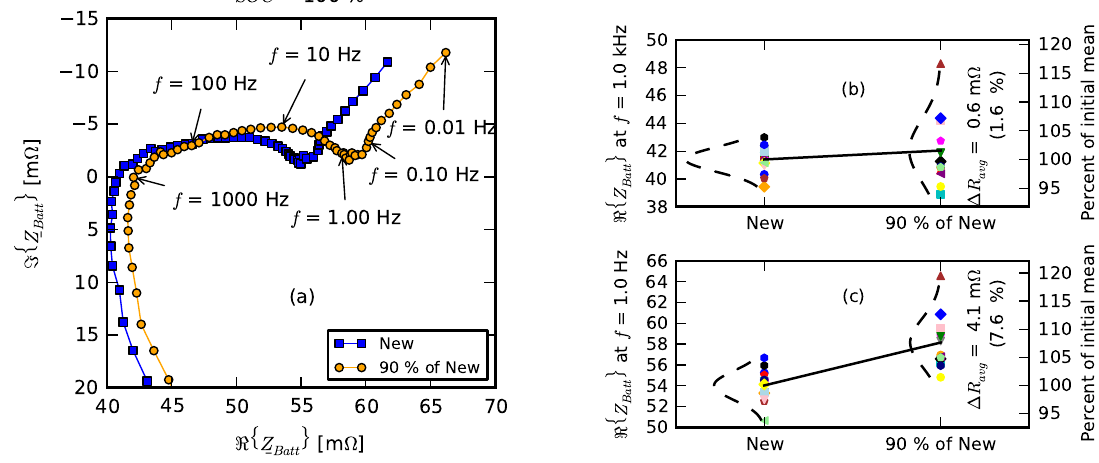
Figure 5. Impedance changes during single-cell aging. ( a ) average impedance spectra; ( b ) real part change for individual cells at f = 1 kHz; ( c ) real part change for individual cells at f = 1